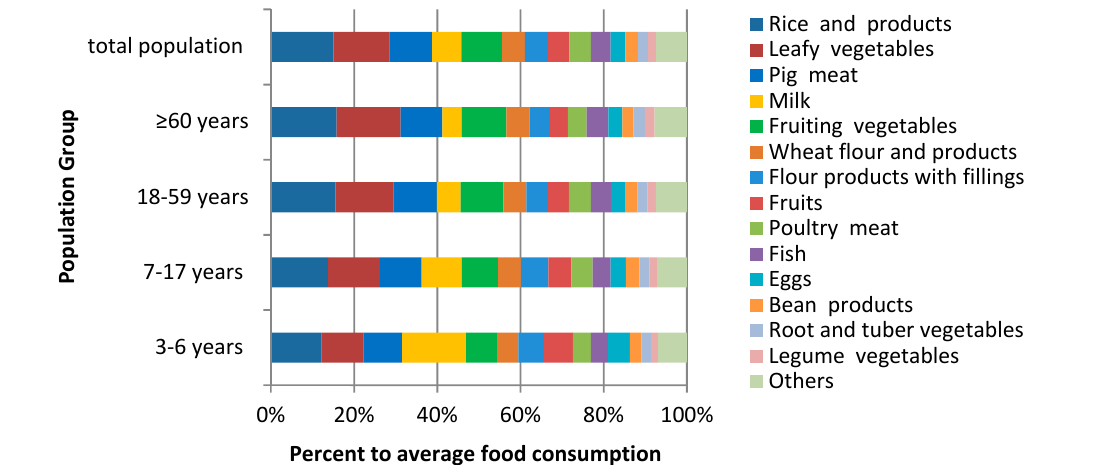
Figure 1. Average food consumption for various age groups.